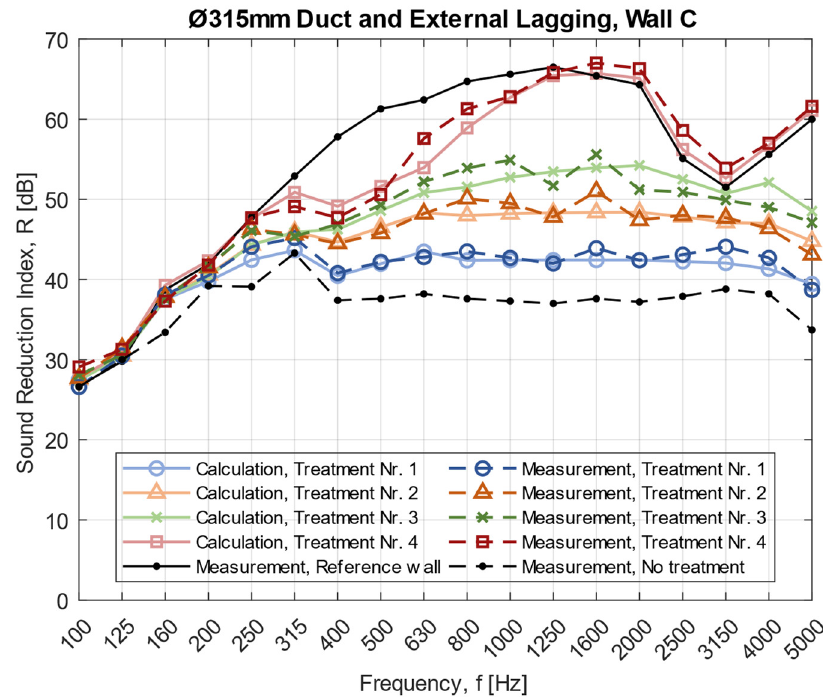
Figure 6. Theoretical models compared to measurements with external lagging as acoustic treatment. Ventilation duct with Ø315 mm through wall C with a sound reduction index of R w = 54 dB. External lagging is mounted at partial lengths of 0.6–1.8 m (Treatment 1–3) and full length (Treatment 4) with 50 mm stone wool, density of 100 kg/m 3 , closest to the wall.